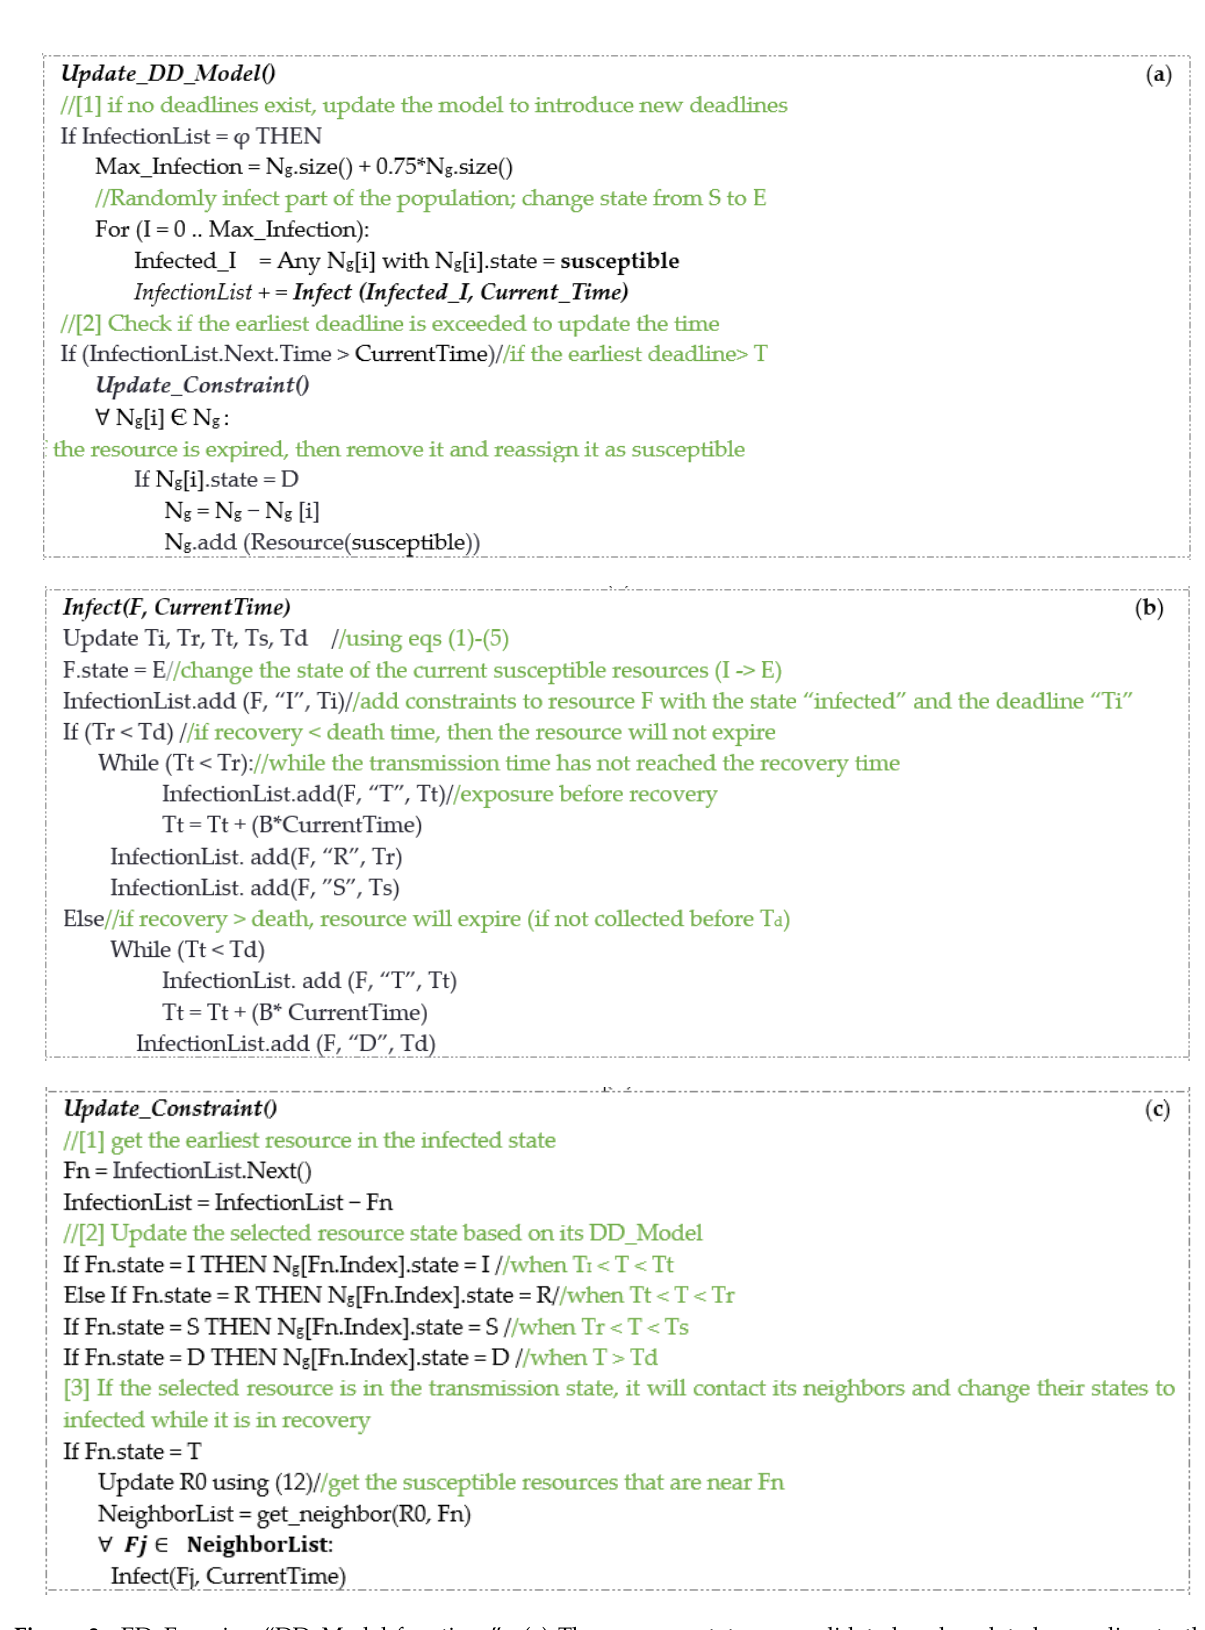
Figure 3. ED_Foraging “DD_Model functions”. ( a ) The resource states are validated and updated according to the DD_Model. ( b ) The expected time constraint of each resource is computed and added to the resource event list L t . ( c ) The resource constraint is updated depending on the resource’s current state and expected future events stored in the event list L t